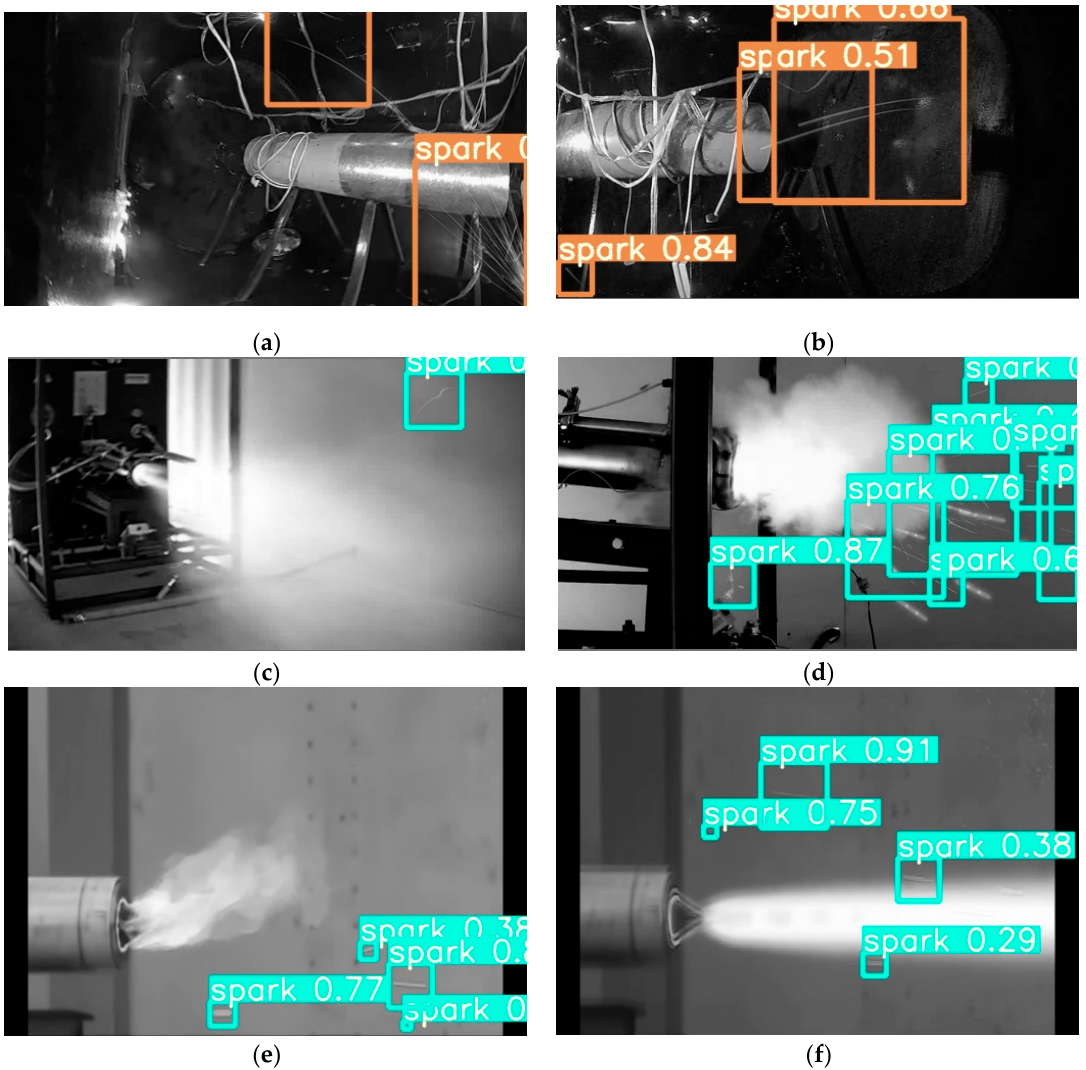
Figure 15. The SAVSDN spark detection results in different images. Each of the boxes is a result of the model, where the words on each box represent the category and the numbers show the confidence level. ( a , b ) demonstrate the detection result of SAVSDN on the SEAS data set; ( c – f ) show the detection results of SAVSDN on other engines.